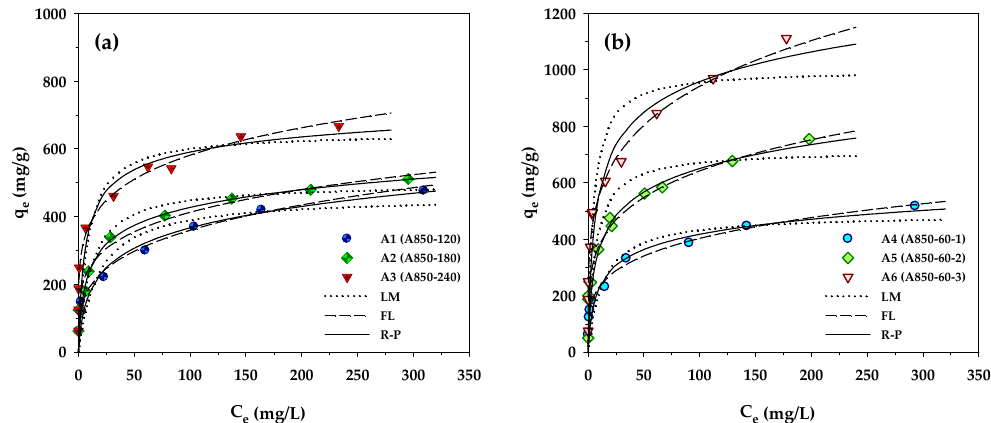
Figure 4. Adsorption isotherms at 35 °C of MB dye on longan seed-activated carbons prepared by ( a ) the two-step activation method, and ( b ) the OTA method.